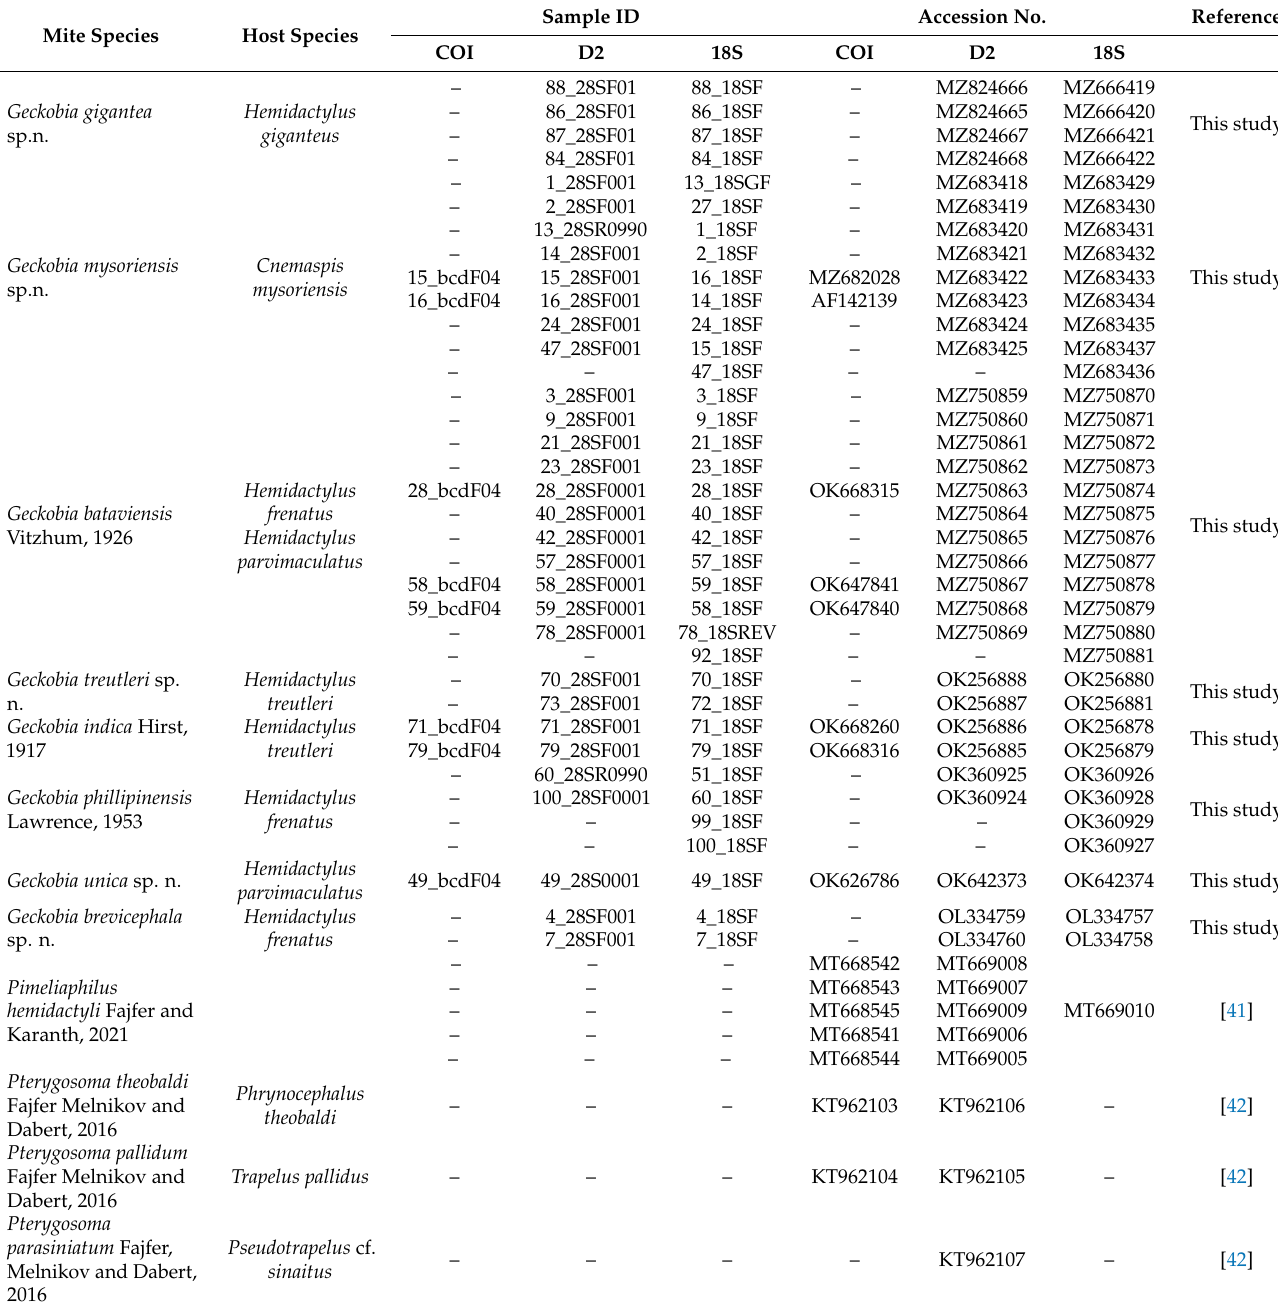
Table 2. Mites and sequences used in this